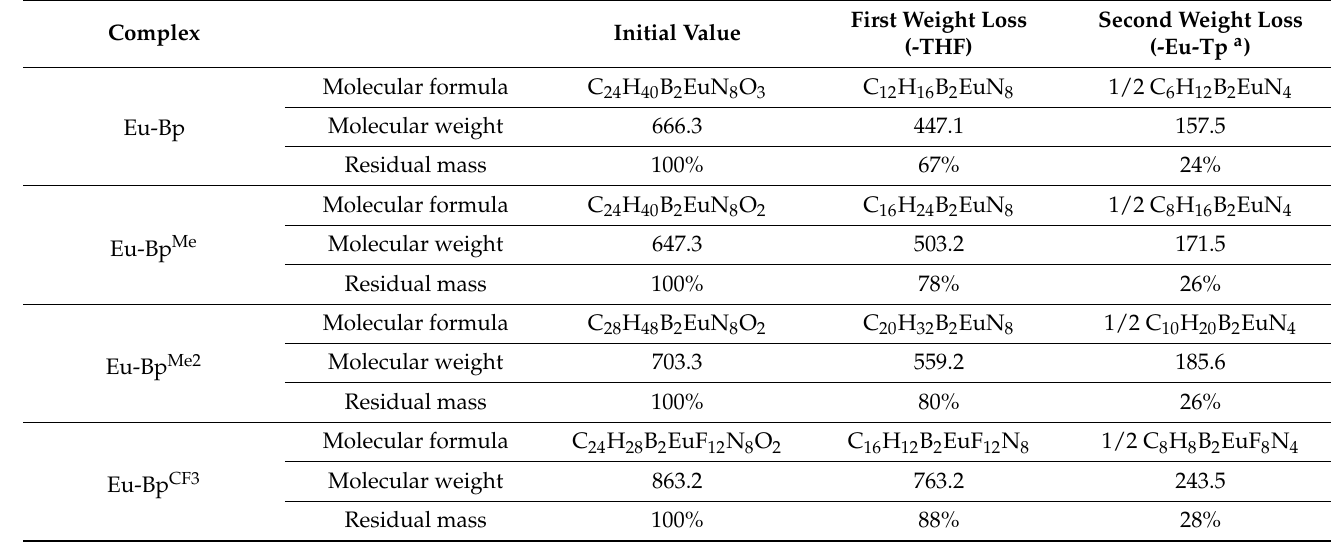
Table 3. Theoretical calculation of thermogravimetric residual mass of the four Eu(II)